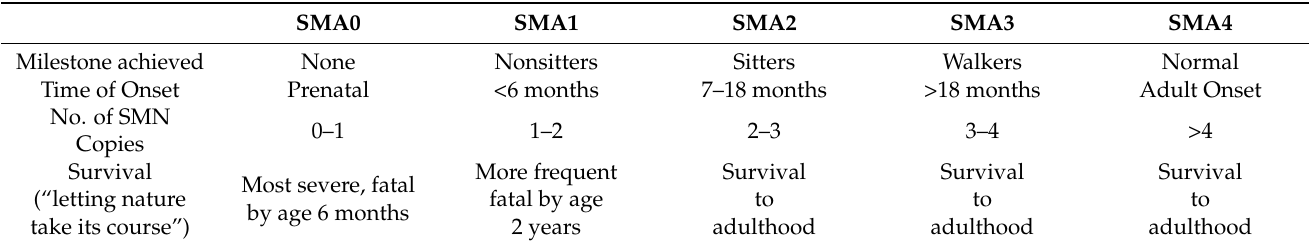
Table 1. Spinal muscular atrophy (SMA)